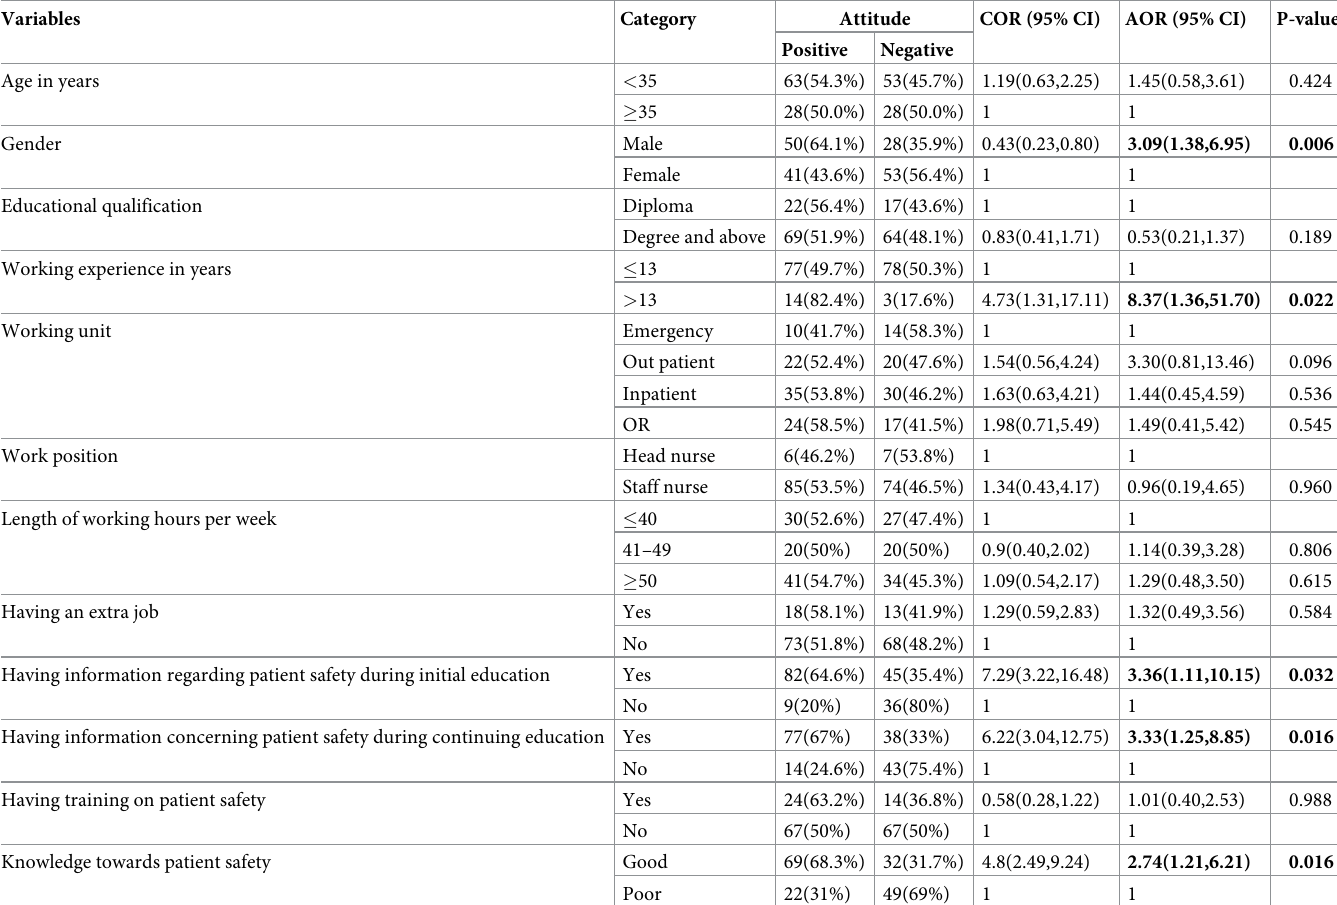
Table 4. Bivariable and multivariable logistic regression analysis of factors associated with attitude towards patient safety among nurses working at Asella Referral and Teaching Hospital, Asella, Ethiopia, 2021, [n =